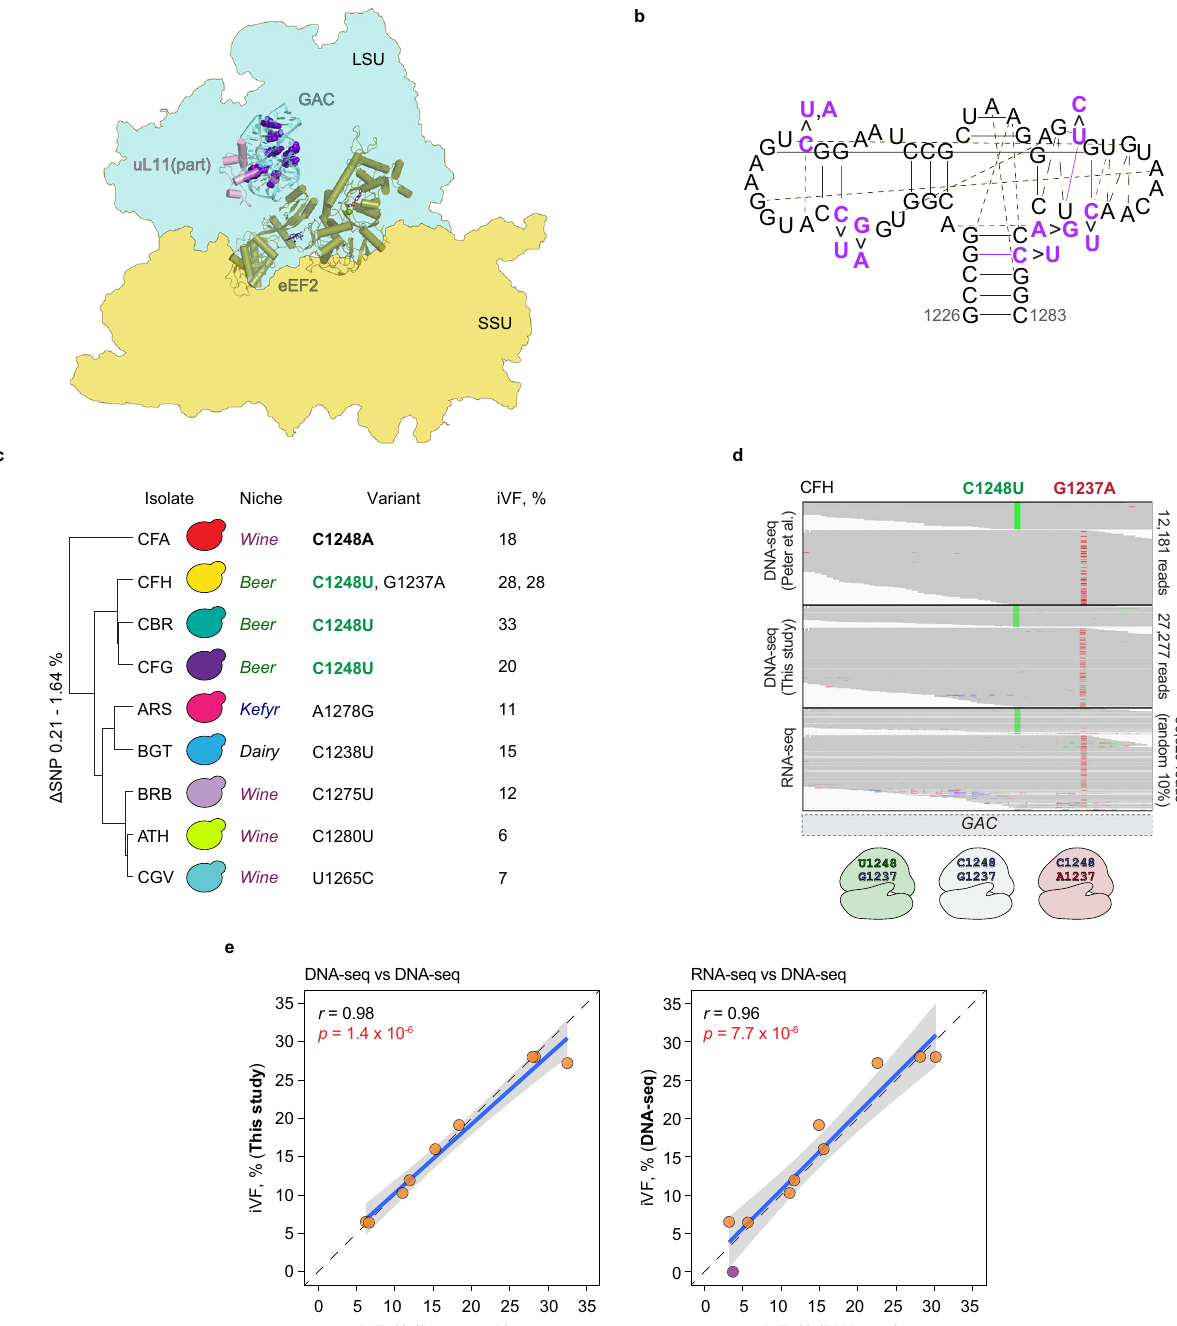
Fig. 6 | Variability in the GTPase-associated center (GAC). a The GAC interacts withtranslationalGTPaseeEF2(green)inthe80Syeastribosome(basedonref.68; LSU is shown in blue, SSU is shown in yellow). Part of ribosomal protein uL11 is shown in pink. Variant positions are shown in purple with the spherical repre- sentation. b ThesecondarystructureoftheGAC.Variantsitesandtheirinteractions are denoted in purple, interactions are shown in lines and weaker (or probable) interactions are shown with dashed lines. c Hierarchical clustering of the isolates withSNVsintheGAC(25Snomenclature)basedonnon-rDNAgenome-widesingle- nucleotidepolymorphism(SNP)differencesfromref.32.Boldhighlightsaposition with more than one variant; green indicates a shared variant. d Continuous rRNA andrDNAreads(fromthisstudyandref.32)ofisolate “ CFH ” (horizontalgraylines) mapped to the GAC. Variant nucleotides are indicated in green and red, with 3 possiblevariant combinations in the 25S rRNA shown below. Due to the large read coverage of the RNA-seq data(over300,000continuousGAC reads),only random